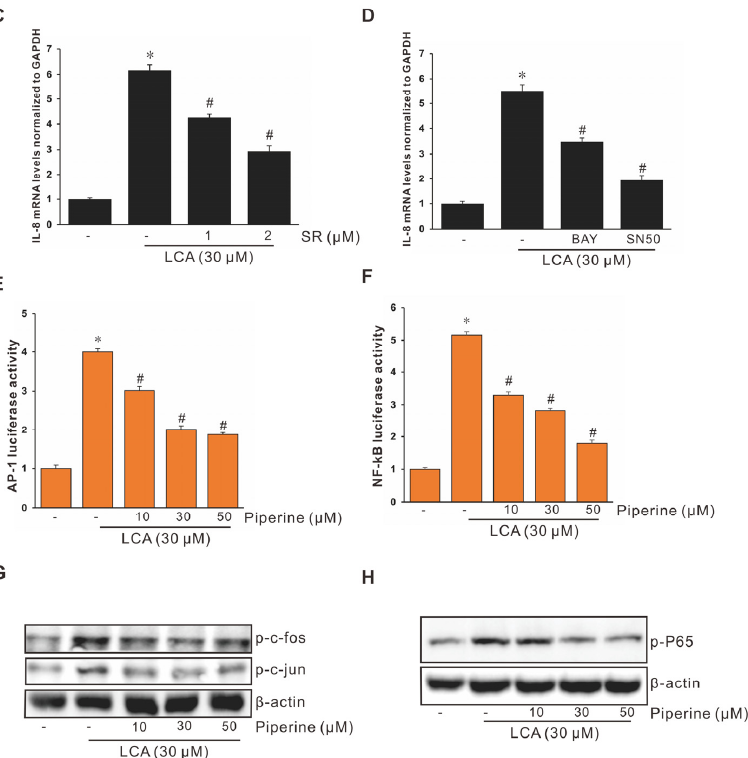
Figure 2. Piperine Inhibits LCA-Induced IL-8 by Suppressing the Transcriptional Activities of AP-1 and NF- κ B in HCT-116 Cells. ( A ) The IL-8 promoter was sequentially deleted in the 5 ′ -flanking region, and the promoter luciferase construct was transiently transfected into HCT-116 cells. These transfected cells were incubated with 30 µ M LCA for 4 h, and the luciferase activity was measured using a luminometer. Data represent the mean ± SEM from three experimental trials. * p < 0.05 versus –133; # p < 0.05 versus –98. ( B ) The IL-8 promoter was mutated at the NF- κ B and AP-1 binding sites (mNF- κ B and mAP-1) and the promoter luciferase construct was transiently transfected into HCT-116 cells. The transfected cells were incubated with 30 µ M LCA for 4 h, and the luciferase activity was measured using a luminometer. Data represent the mean ± SEM from three experimental trials. * p < 0.05 versus LCA only. HCT-116 cells were pretreated with SR-11302 (SR ( C )), BAY-11-7082 (BAY, 20 µ M ( D )), or SN50 (50 µ g/mL ( D )) for 1 h and incubated with 30 µ M LCA for 4 h, followed by mRNA extraction and RT-qPCR to determine IL-8 secretion level. HCT-116 cells were transiently transfected with AP-1 luciferase reporter construct ( E ) or NF- κ B luciferase reporter construct ( F ). These transfected cells were pretreated with piperine (10, 30, and 50 µ M) and incubated with 30 µ M LCA for 4 h, and the luciferase activity was measured using a luminometer. Data represent the mean ± SEM from three experimental trials. * p < 0.05 versus control; # p < 0.05 versus IL-8. ( G ) HCT-116 cells were pretreated with piperine (10, 30, and 50 µ M) and incubated with 30 µ M LCA for 4 h; cell lysates were analyzed for phosphorylated c-Fos and c-Jun level using western blotting. ( H ) HCT-116 cells were pretreated with piperine (10, 30, and 50 µ M) and incubated with 30 µ M LCA for 4 h, cell lysates were analyzed for phosphorylated p65 level using western